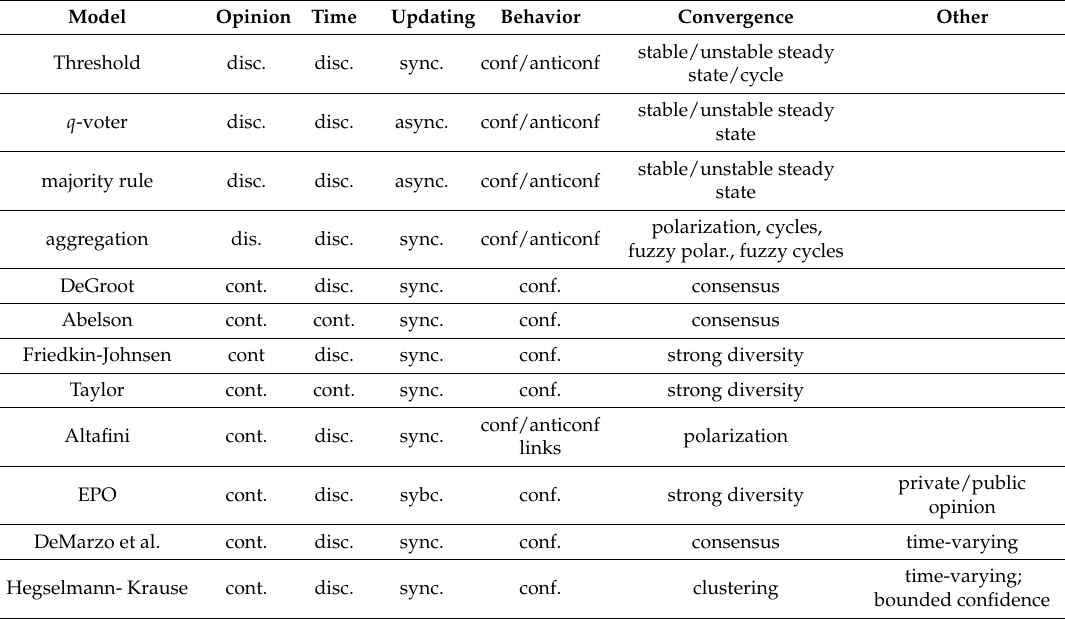
Table 1. Summary of the main properties of the various models. disc. = discrete, cont. = continuous, sync. = synchronous, async. = asynchronous, conf. = conformist, anticonf. = anticonformist. Only most typical convergence results are